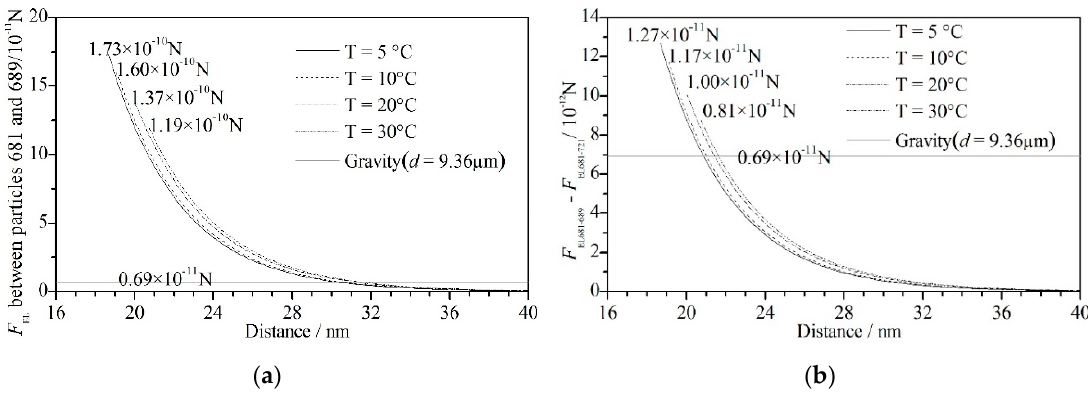
Figure 10. Comparisons of F EL and the gravity of the primary particle with diameters of 9.36 μ m and efficient densities ρ s - ρ of 1650 kg/m 3 . ( a ) The electrostatic double layer force between particles #681 and #689, F EL681–689 of different particle net distances at temperatures of 5 °C, 10 °C, 20 °C, and 30 °C; ( b ) the difference in electrostatic double-layer forces acting on particle #681, F EL681–689 – F EL681–721 with different particle net distances in the cases of 5 °C, 10 °C, 20 °C, and 30 °C.